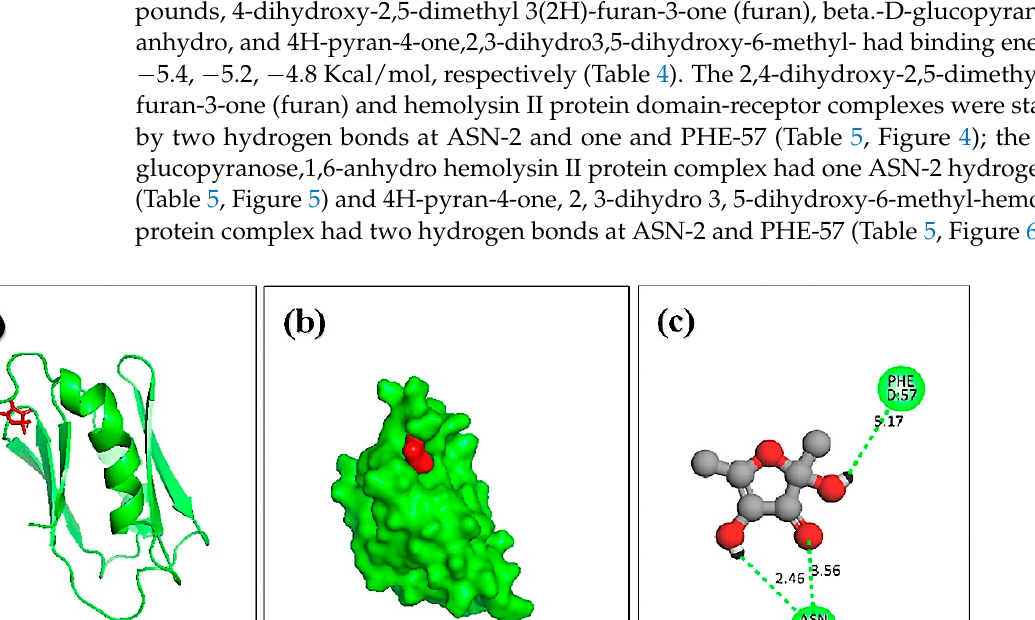
Table 5. The protein–ligand interaction and identification of binding residues.